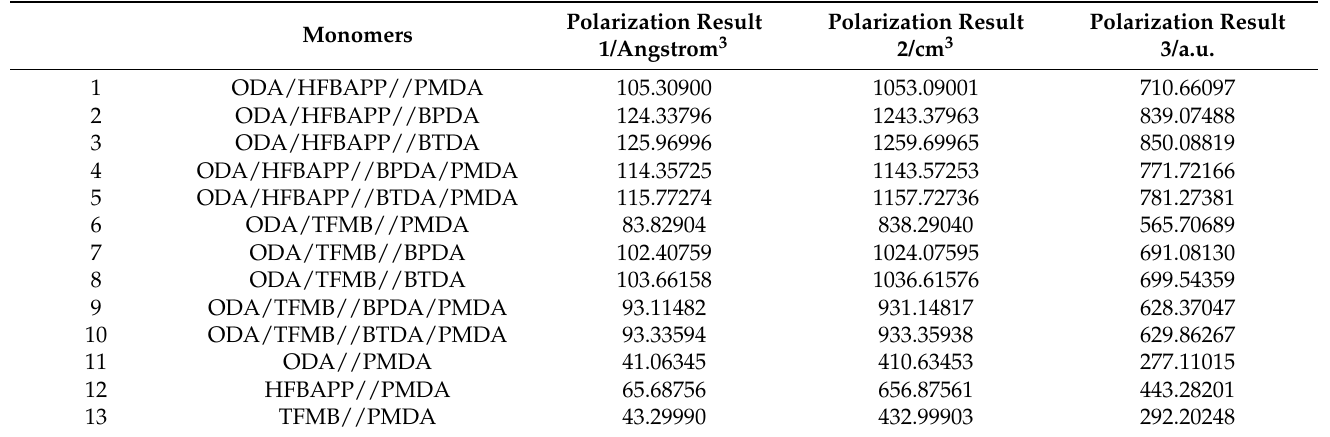
Table 1. Simulation results of the polarizability of PI films composed of each monomer group.